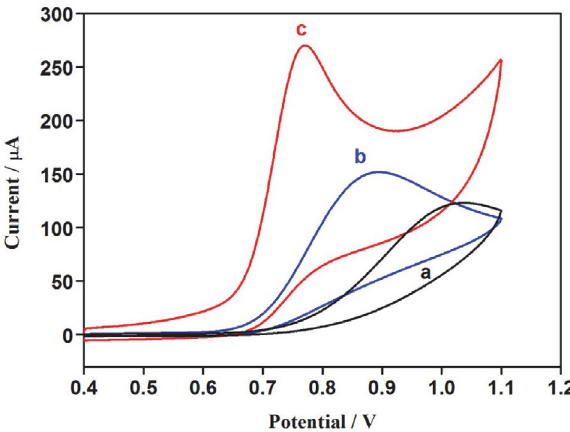
Fig 5. CV curves of different electrodes in PBS (0.2 M, pH 7.4) in the presence of 5.0 mM nitrite at 100 mV s –1 : bare GCE (a), PE- DOT/CNCC/GCE (b), PEDOT/Fe 3 O 4 -CNCC/GCE (c).